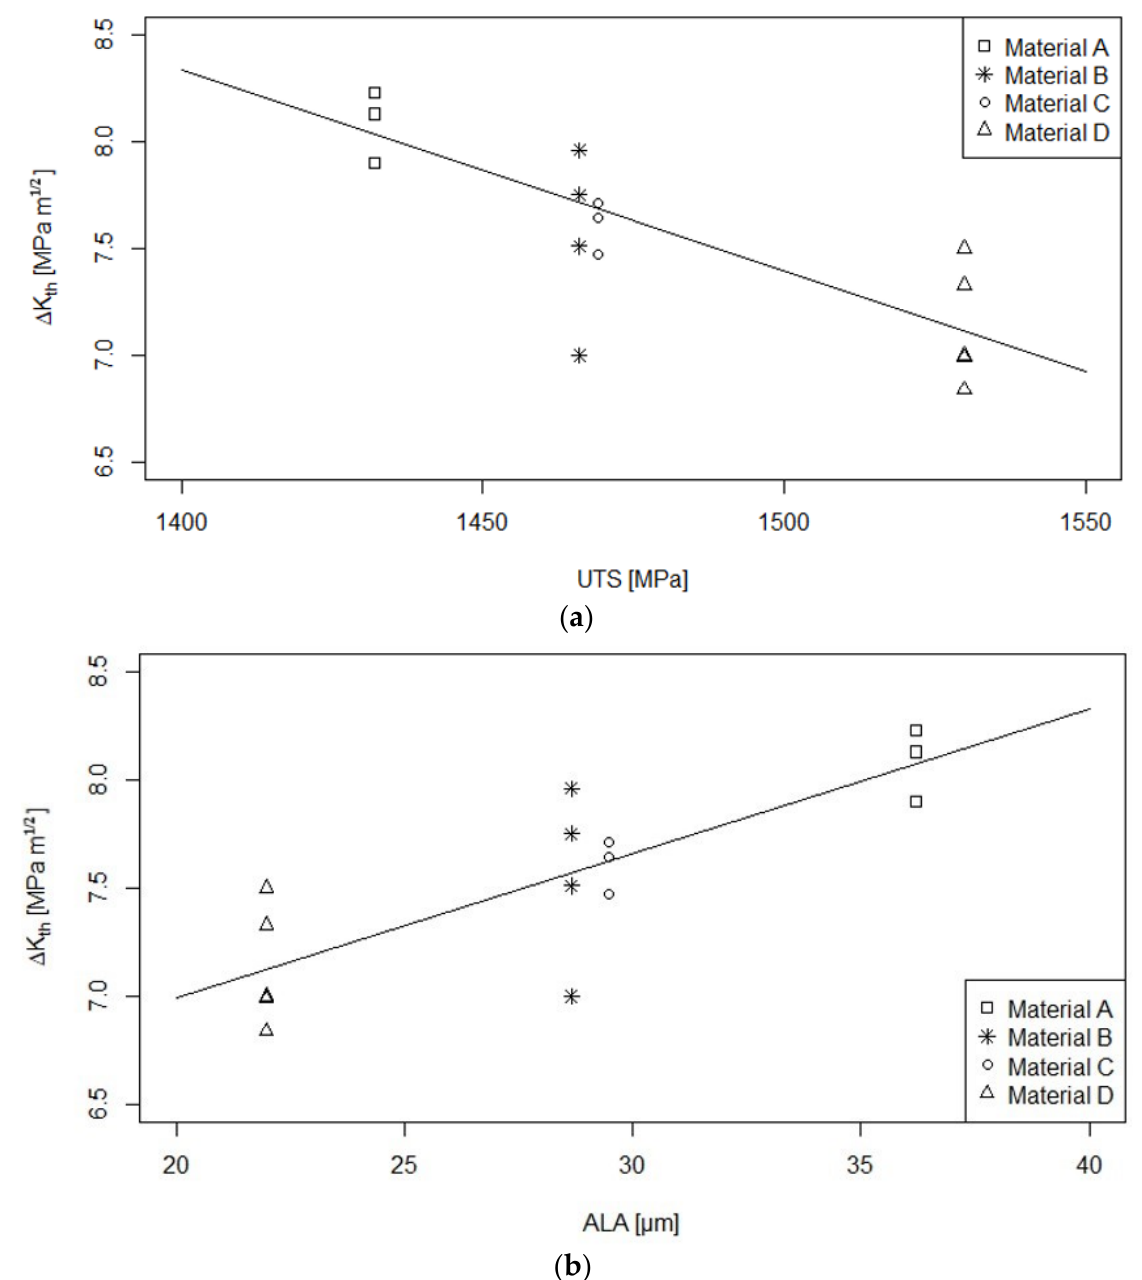
Figure 11. Linear correlations between ( a ) the mechanical parameter UTS and the fracture mechanical parameter ∆ K th , ( b ) the microstructural parameter ALA and the fracture mechanical parameter ∆ K th ; the samples from the plastically deformed Material B are marked by asterisks.